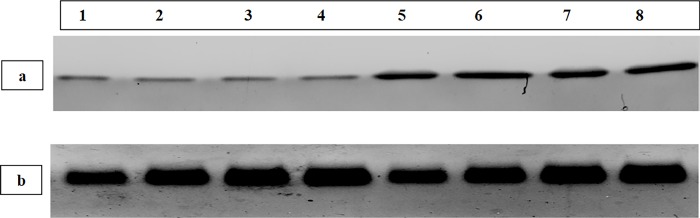
Western blot analysis showing: a) TNFAIP3 protein; and b) the housekeeping protein (β-actin) in skin biopsies. Bands 1–4 show TNFAIP3 (upper figure) and β-actin (lower figure) in the psoriatic skin lesions of patients number 2, 8, 12 and 15.Bands 5–8 show TNFAIP3 (upper figure) and β-actin (lower figure) in skin biopsies of the normal control subjects 1, 2, 3 and 4.